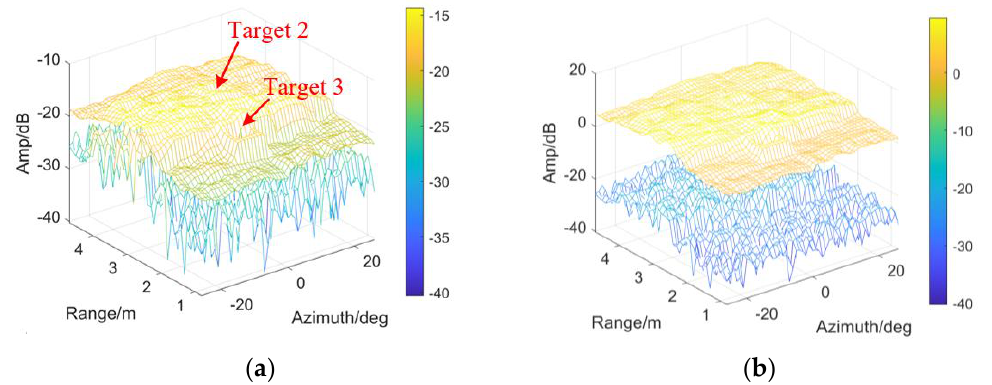
Figure 9. The outputs of CA-CM-CFAR detectors by employing ( a ) Student-t test statistics; ( b ) Gaussian test statistics.